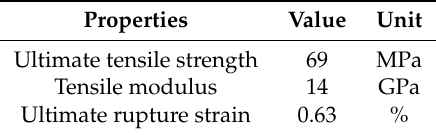
Table 2. Sprayed glass fiber-reinforced polymer (GFRP) properties.